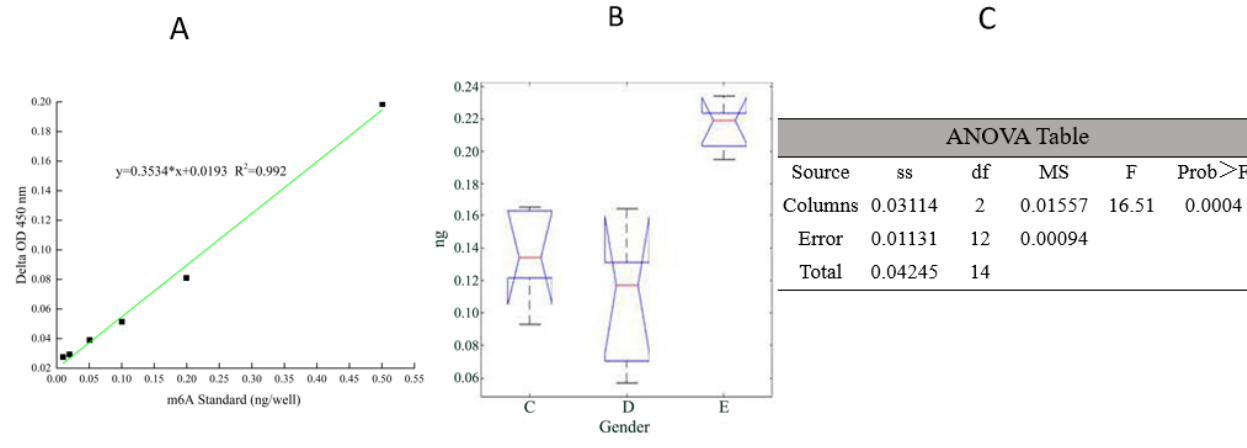
Fig. 4 - Correlation diagram of N 6 -methyladenosine (m 6 A) ribonucleic acid methylation results. ANOVA=analysis of variance. df=degrees of freedom; F=F-ratio; MS=mean square; SS=sum of